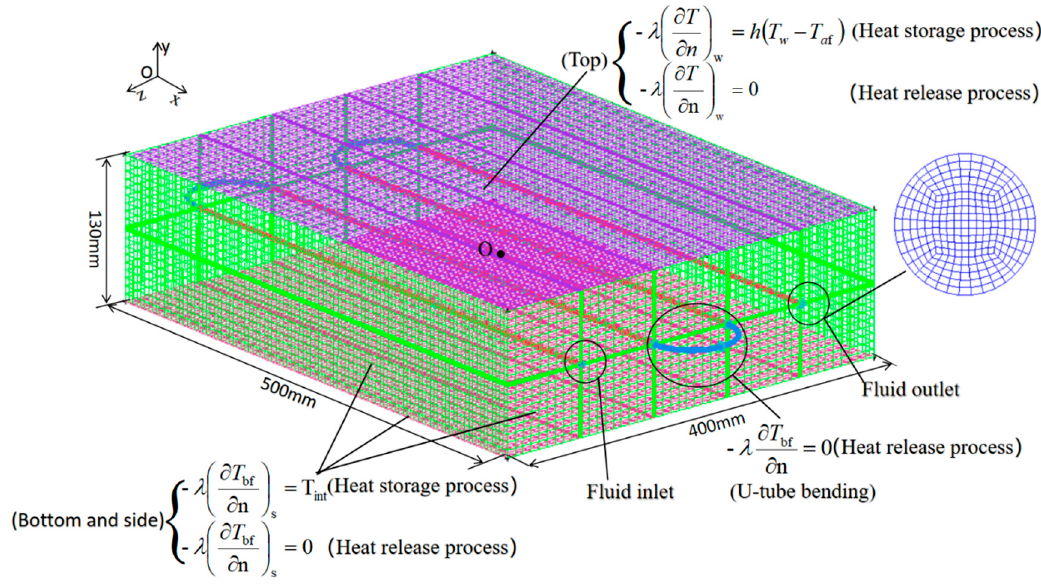
Figure 7. The grid generation for the backfill body.